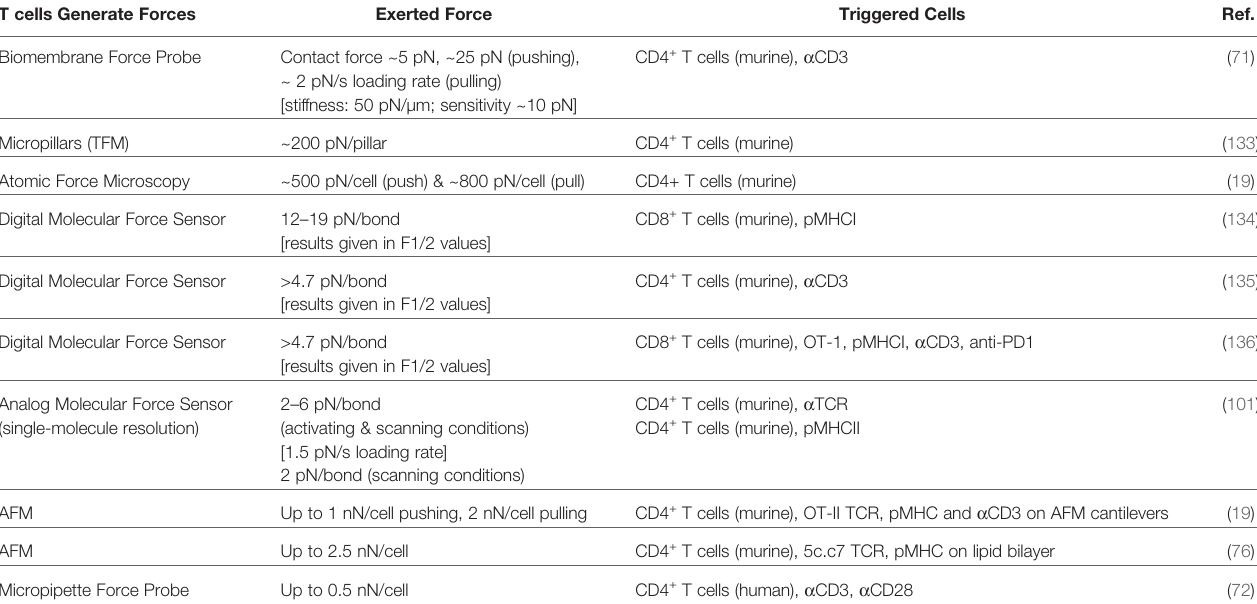
TABLE 2 | Overview of published articles investigating mechanical forces exerted by T cells. T cells Generate Forces Exerted Force Triggered Cells